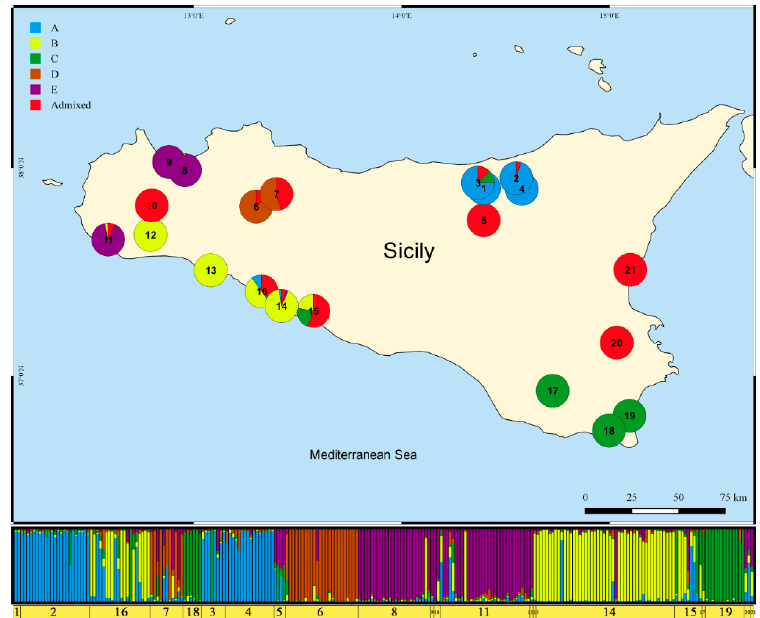
Figure 1. Genotypic structuring of 245 Sicilian pond turtles ( Emys trinacris ) from 21 sampling sites for K =5 using 16 microsatellite loci based on the STRUCTURE analysis. Distinct clusters are colour-coded; samples are arranged according to the numbers of the pooled sampling sites (Table S1). Within each cluster, an individual turtle is represented by a vertical segment that reflects its ancestry. Mixed ancestries are indicated by differently coloured sectors corresponding to inferred genetic percentages of the respective cluster. Colours of pooled sampling sites in the map correspond to STRUCTURE clusters; slices represent turtles with mixed ancestries or conflicting cluster assignment (percentages).